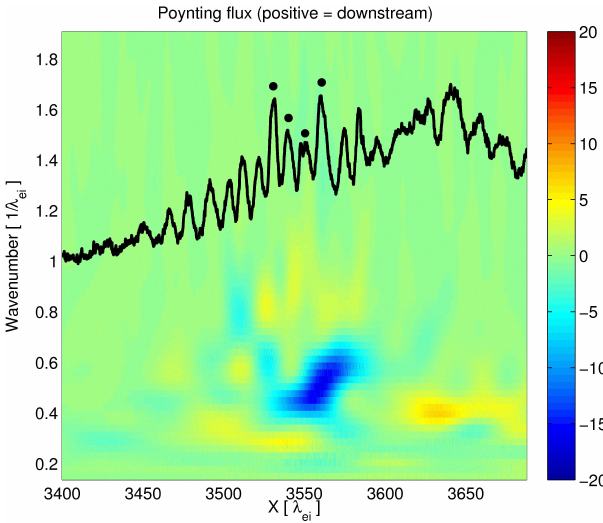
Fig. 8. Same as Fig. 7 at t(cid:127) ci = 9 . 5. of 78 linearly spaced wavenumbers kc/ω pe from 0 . 2 to 1 .